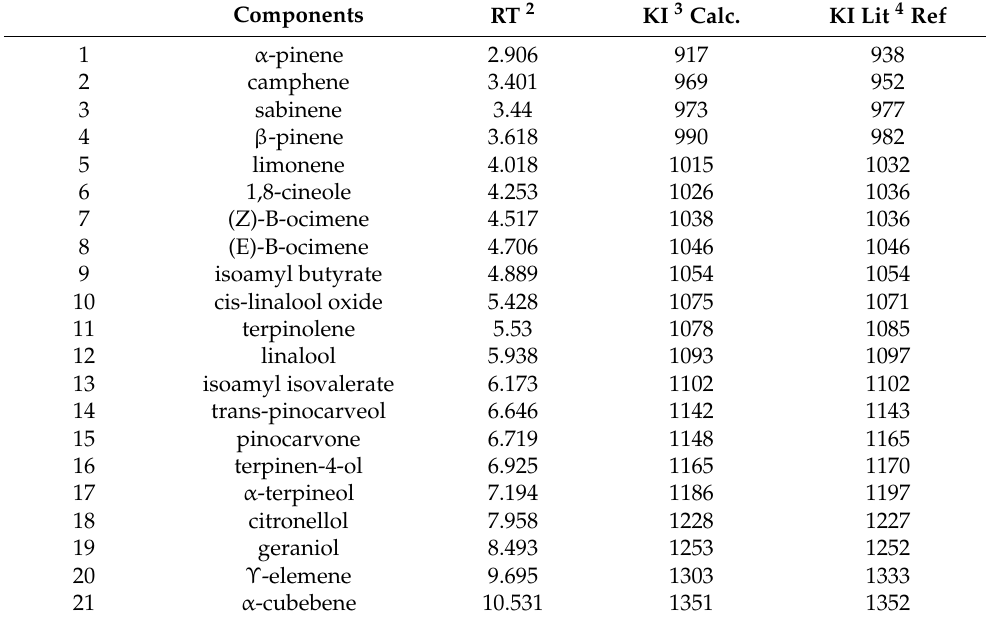
Table 6. Identified chemical components in kunzea oil 1 extracted from K. ambigua